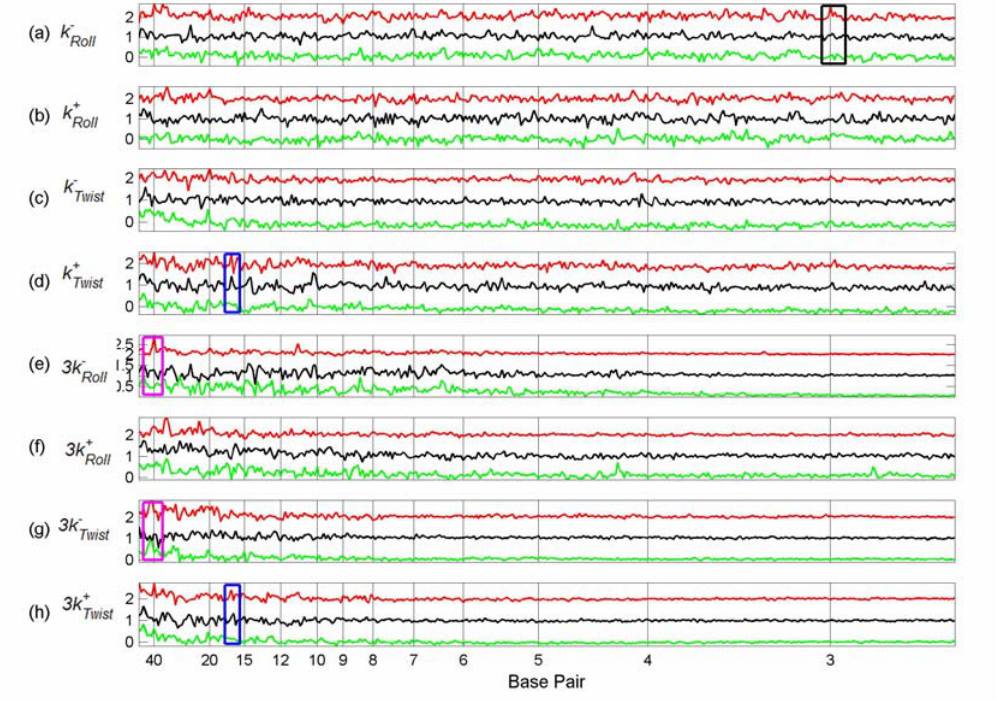
Figure 6-8. Comparison between Flexibility Force Constant Difference Spectra, Partition Coefficient Difference Spectra and Non-flexibility Property Difference Spectra of Tfbs in Chromosome